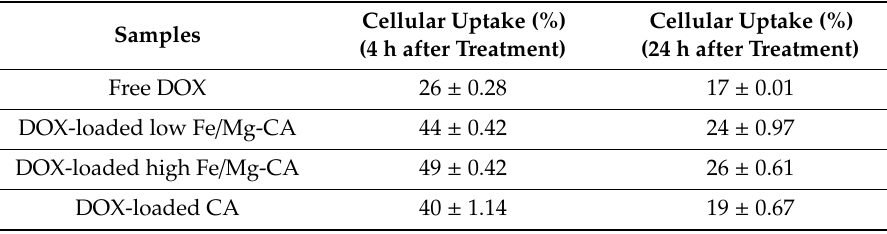
Table 6. Cellular uptake (%) of free DOX, DOX-loaded CA, DOX-loaded low and high Fe / Mg-CA NPs in MCF-7 cells after 4 h and 24 h of treatment.